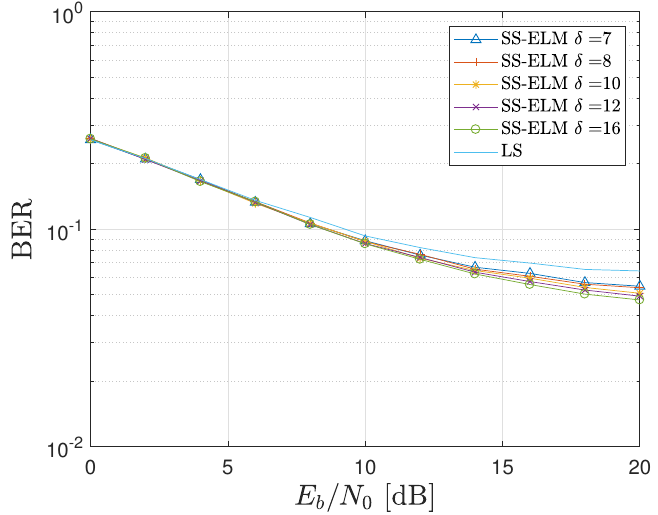
Figure 12. BER of the proposed SS-ELM scheme with δ as parameter and the LS algorithm for system configuration